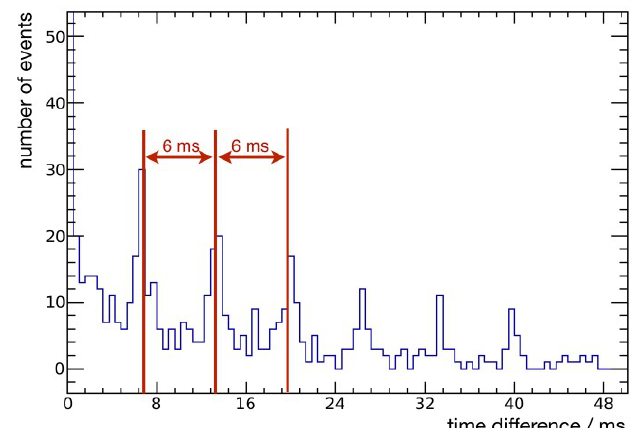
Figure 9. The time-difference histogram measured in front of the treatment room at Helios Klinikum, Aue, Germany, during the operation of a clinical accelerator. In the recorded data, the time structure of the initial beam could be reconstructed with a frequency of around 166